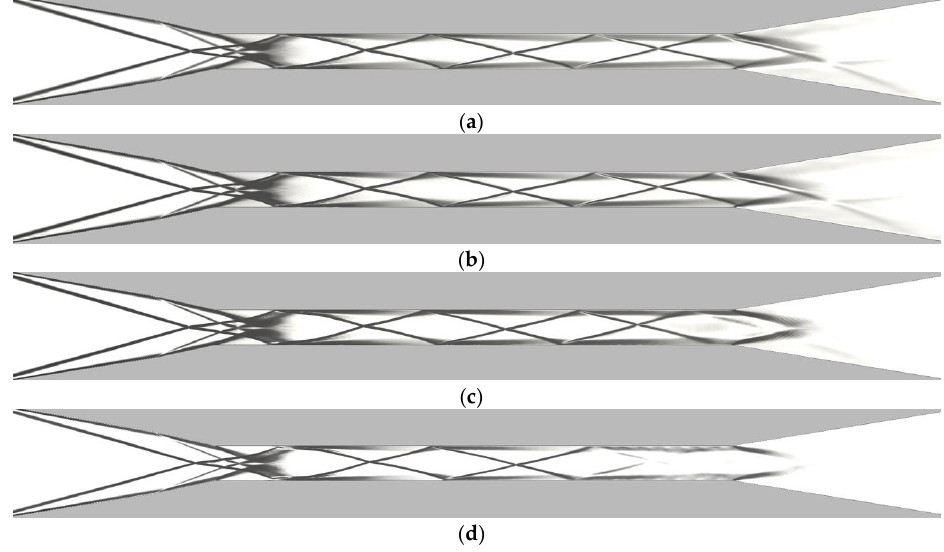
Figure 8. Numerical schlieren images for four simulation cases: ( a ) 2D-equilibrium case; ( b ) 2D-nonequilibrium case; ( c ) 3D-equilibrium case; ( d ) 3D-nonequilibrium case.